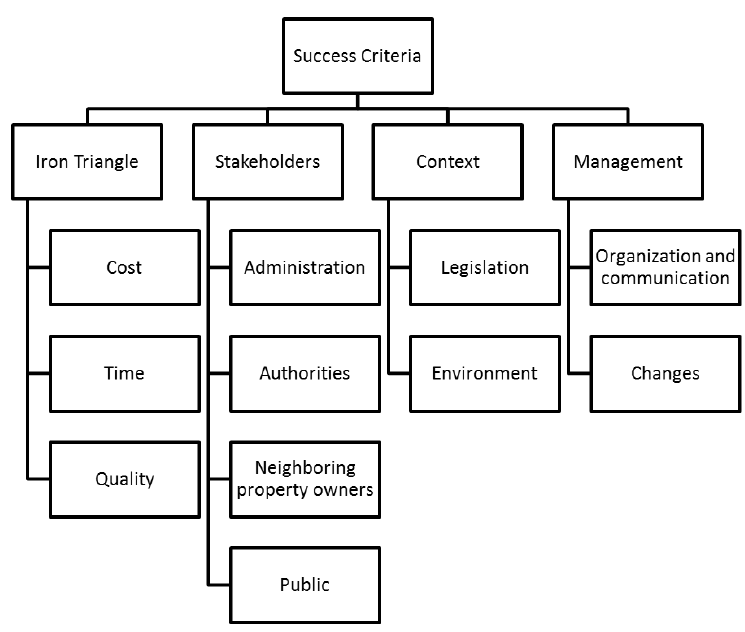
Fig. 2. Success Criteria (source: